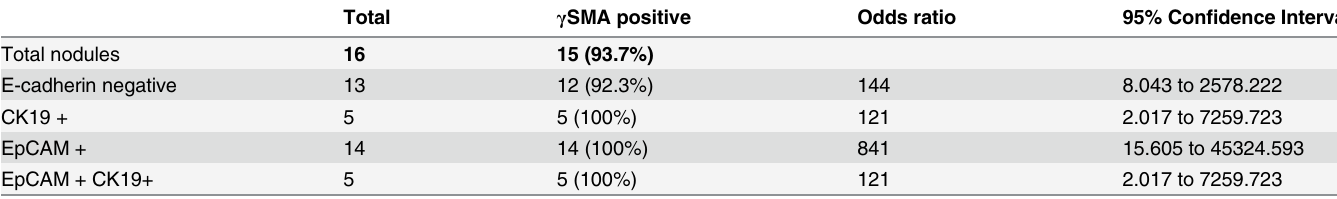
Table 2. Correlation between γ SMA, E-cadherin and progenitor marker expression in paediatric HCC.